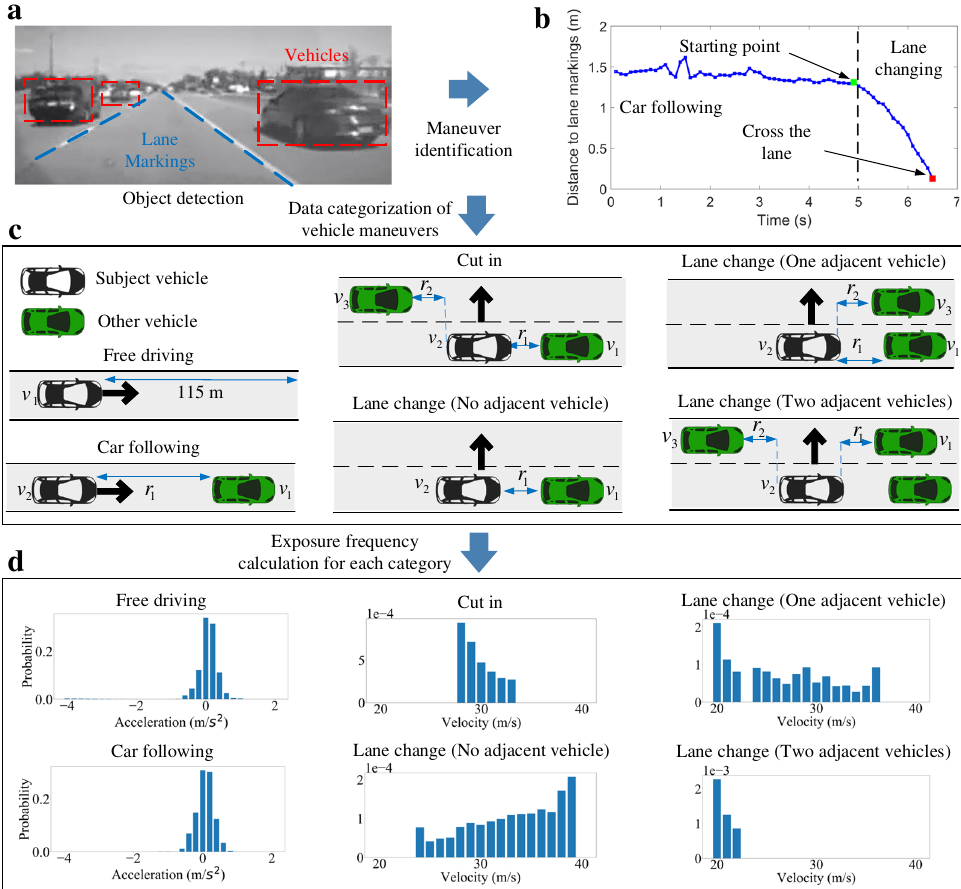
Fig. 2 Data processing of the NDD. a Object detection of vehicles and lane markings for an example frame captured by cameras. b Identi fi cation of lane changing maneuvers by analyzing lateral distance to lane markings. c Data categorization of vehicle maneuvers considering surrounding vehicles. The image of vehicles is previously published at https://commons.wikimedia.org/wiki/File:C3top.png under the Creative Common CC0 1.0 Universal Public Domain Dedication. d Examples of empirical distributions of vehicle maneuvers for each category. States of the examples are r 1 = 30 m v 1 = v 2 = 30 m s − 1 (car following); r 1 = 40 m, r 2 = 21 m, v 1 = v 2 = v 3 (cut in); r 1 = 31 m, v 1 = v 2 (lane change, no adjacent vehicle); r 1 = 20 m, r 2 = 32 m v 1 = v 2 = v 3 (lane change, one adjacent vehicle); and r 1 = 28 m, r 2 = 26 m, v 1 = v 2 = v 3 (lane change, two adjacent